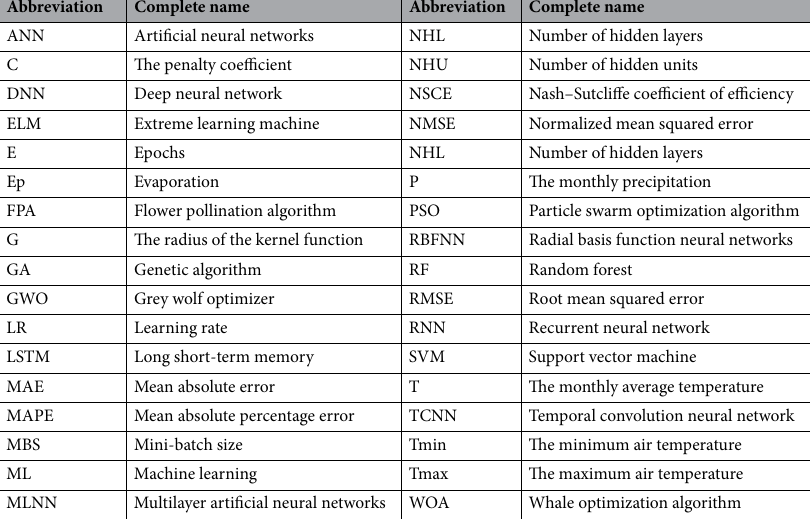
Table 2. List of abbreviations.